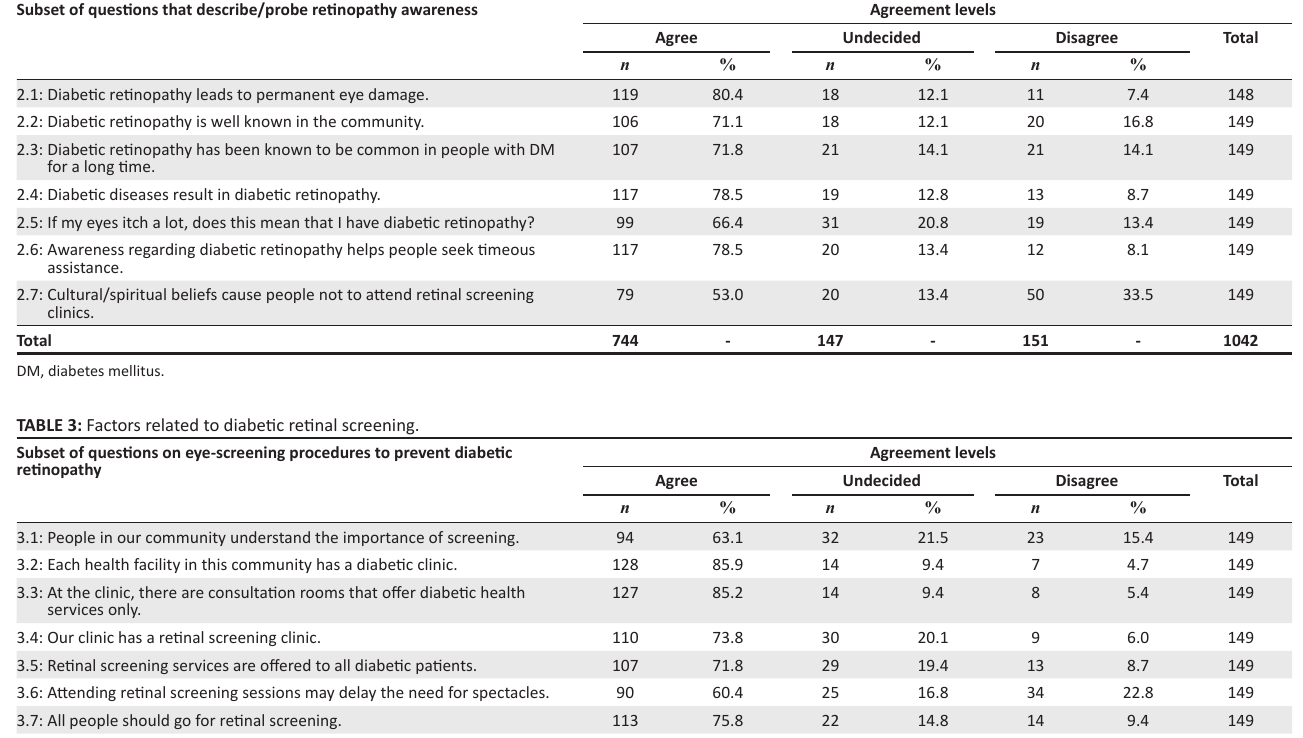
TABLE 2: Study participants’ knowledge about diabetic retinopathy. Subset of questions that describe/probe retinopathy